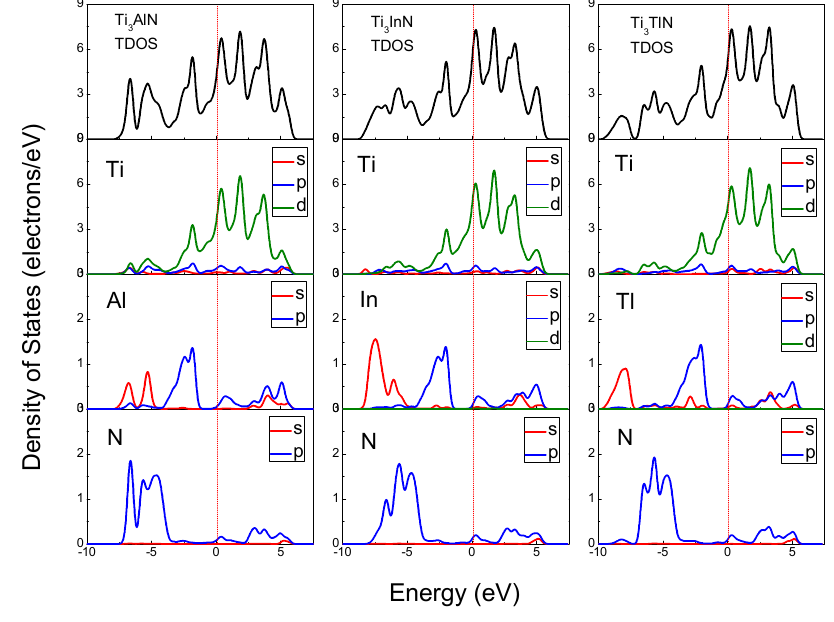
Figure 4. Density of states of Ti 3 AlN, Ti 3 InN, and Ti 3 TlN.